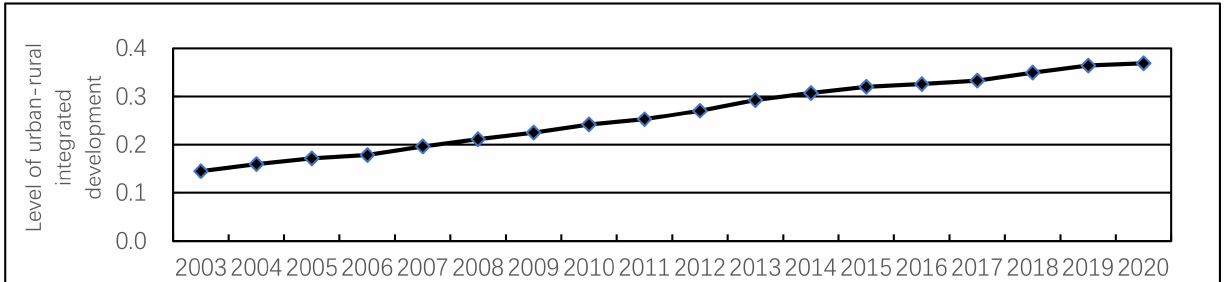
Figure 2. Changes in the level of urban-rural integration